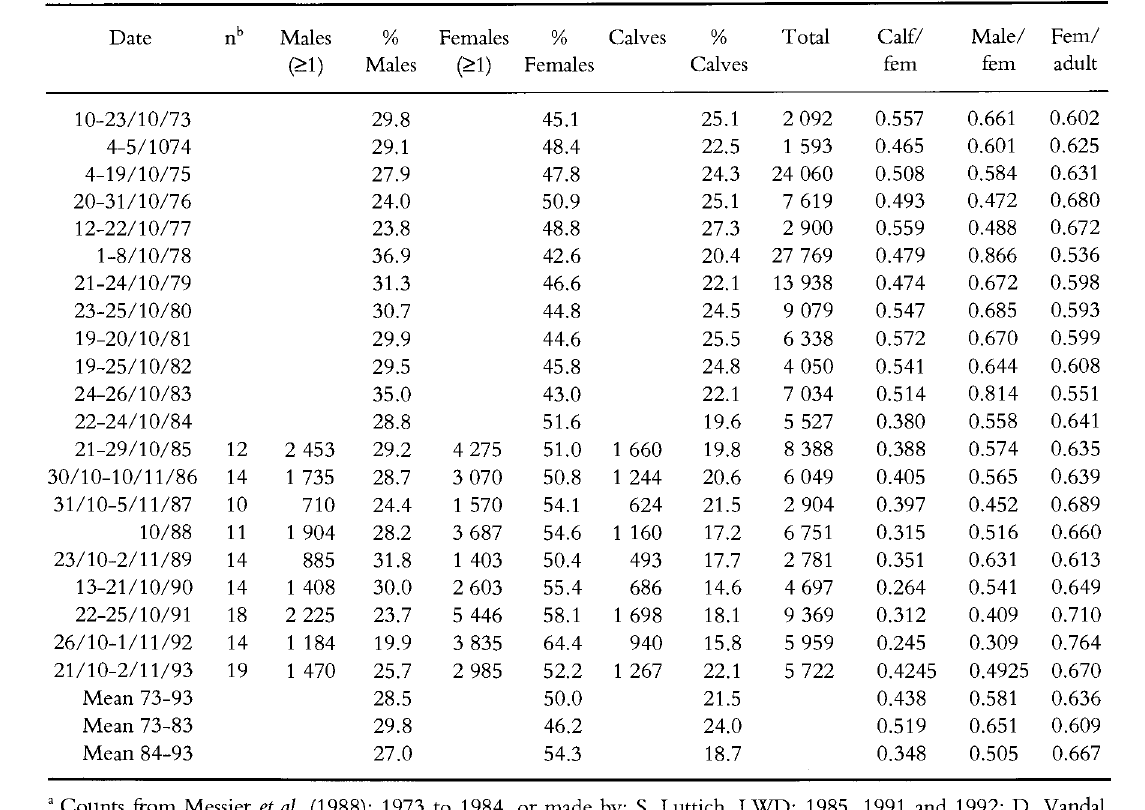
Table 4. Composition counts during the rutting period for the Rivière George Caribou Herd, 1973 to